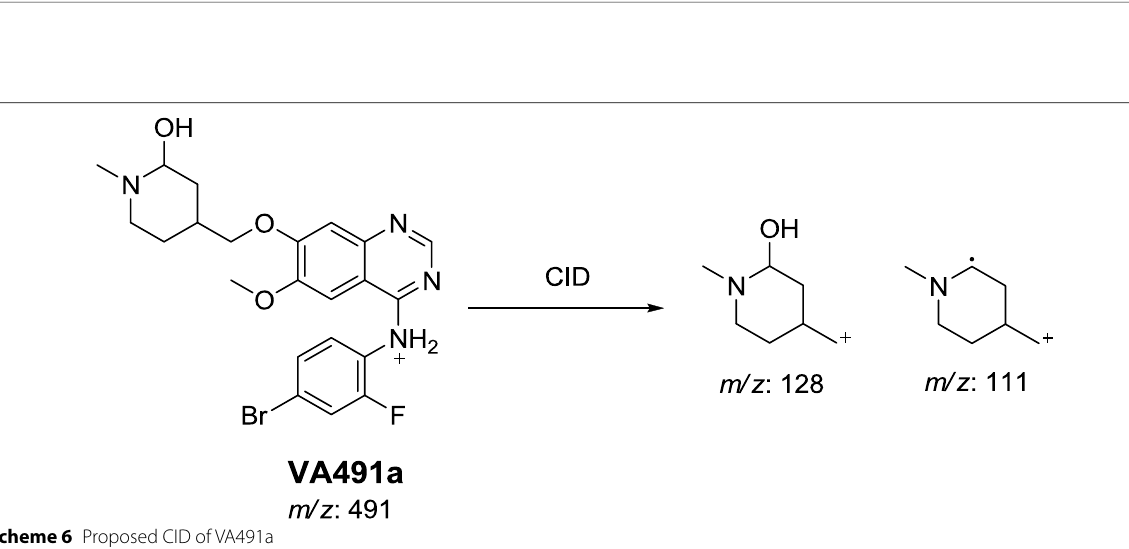
Fig. 4 PI chromatogram of MIP at m/z 491 showing two peaks: VA491a (57.1 min) and VA491b (67.4 min) ( a ), PI mass spectra of VA491a ( b ) and VA491b at m/z 491 ( c )